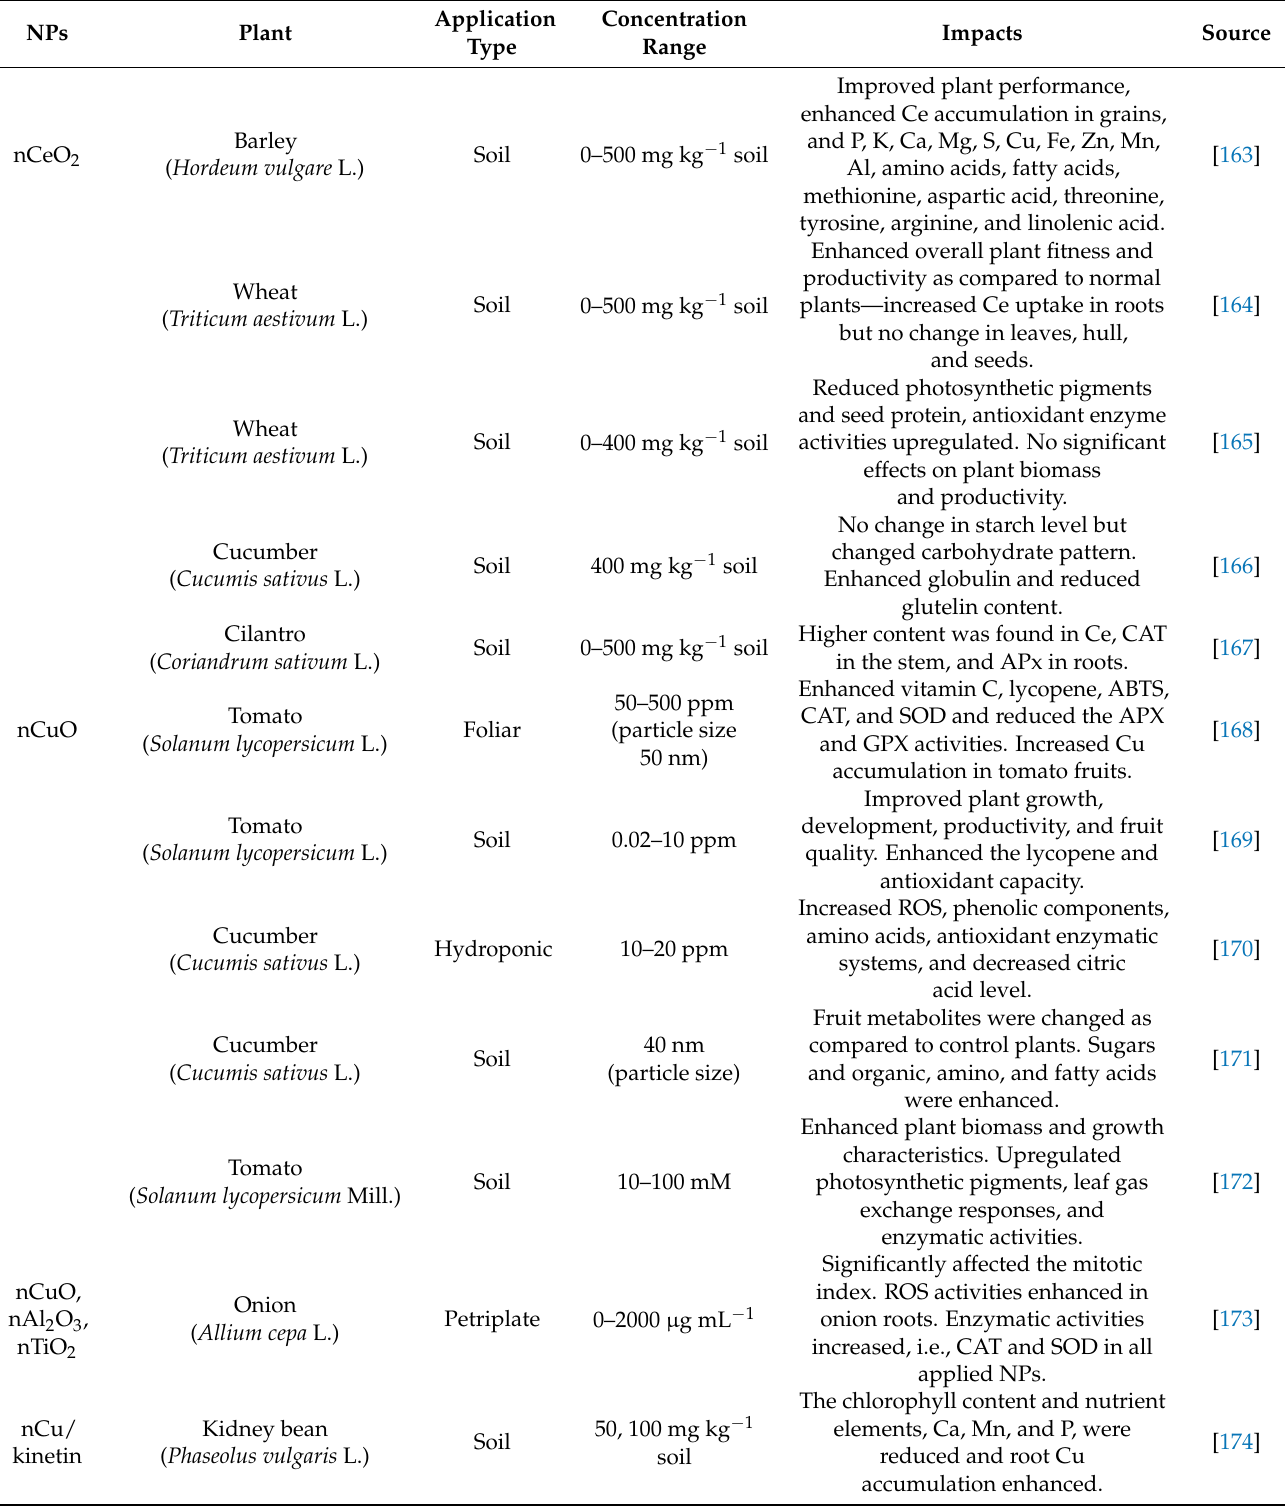
Table 1. Impact of nanoparticles/nano-fertilizers on crops under unfavorable environmental